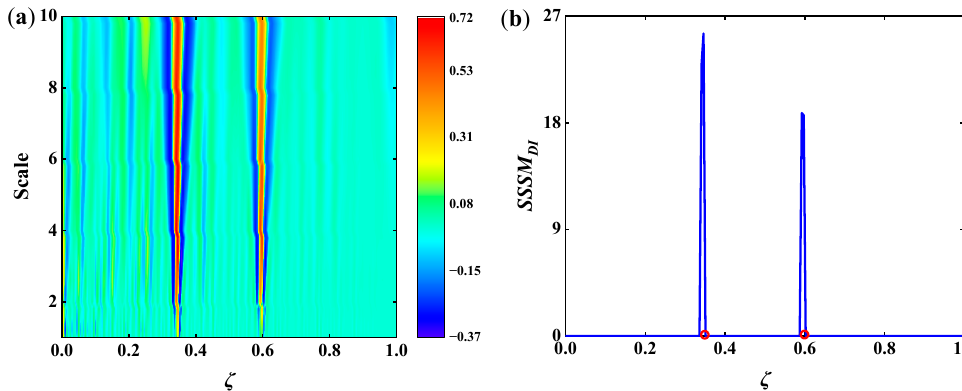
Figure 18. Identification results of cracked cantilever beam under scenario I when γ = 10%: ( a )